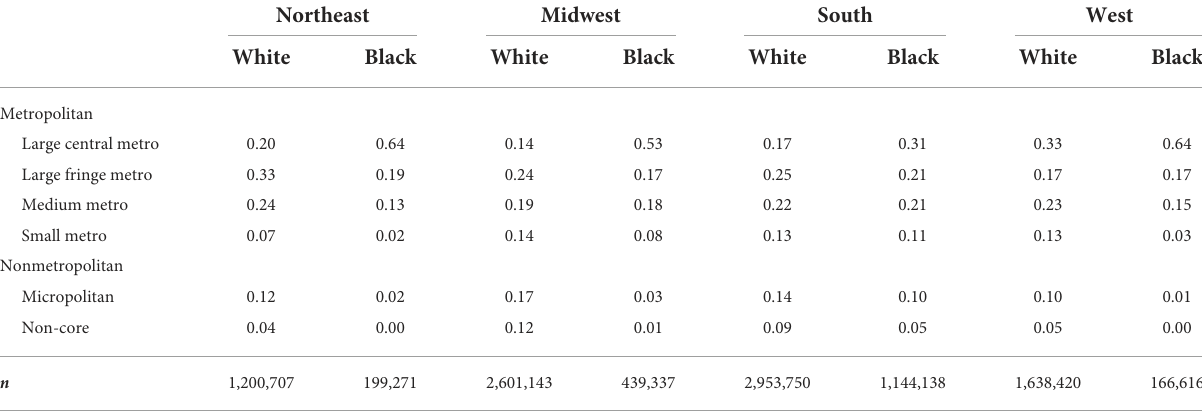
TABLE 4 Distribution of births between 2011 and 2015 across 2006 NCHS Urban-Rural Classification Scheme by region and race. Northeast Midwest South West White Black White Black White Black White